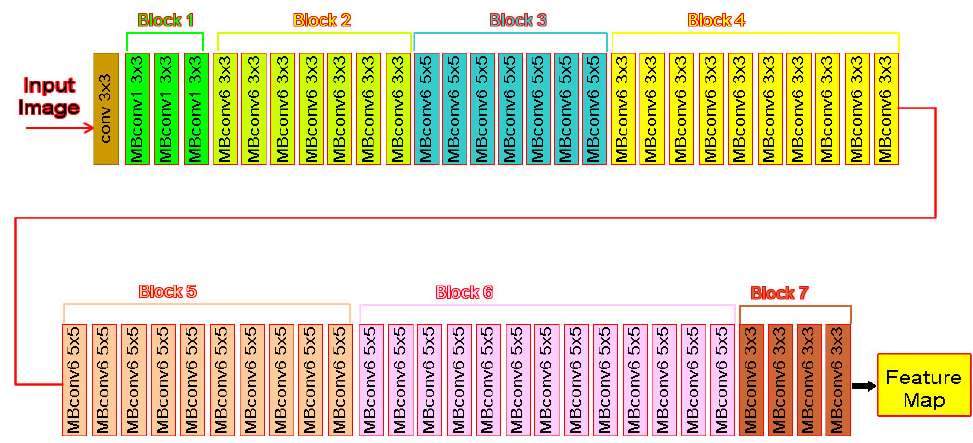
Figure 6. EfficientNetB7 architecture.